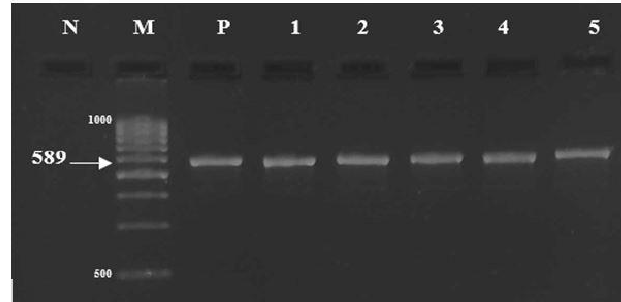
Fig. 3: PCR products of Stx2 gene. Lane M, DNA molecular standard; lane 1-5 positive tested samples giving 589bp product size; lane N, negative control and lane P control